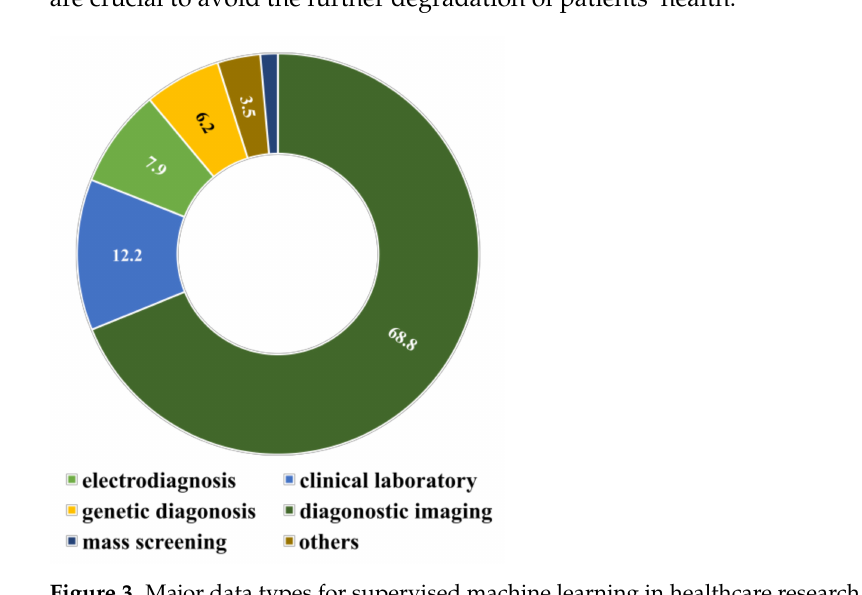
Figure 3. Major data types for supervised machine learning in healthcare